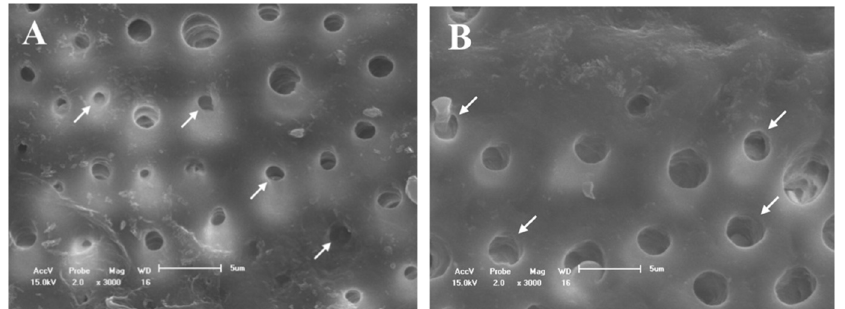
Figure 5. SEM micrographs of the dentine surface morphology at 3000× magnification. ( A ) Fluoride varnish without nanofiber and ( B ) after 6% citric acid challenge. The arrows indicated the partial tubules occlusion with crystal deposition ( A , B ).